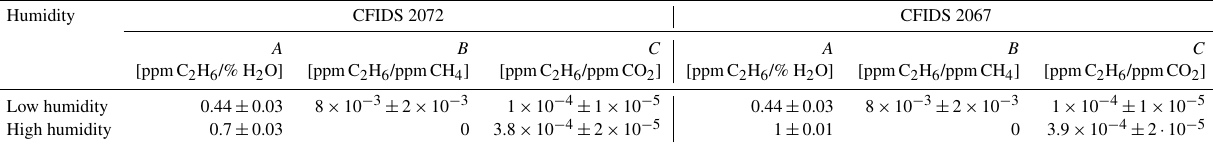
Table 2. Interference correction on C 2 H 6 (Assan et al., 2017).